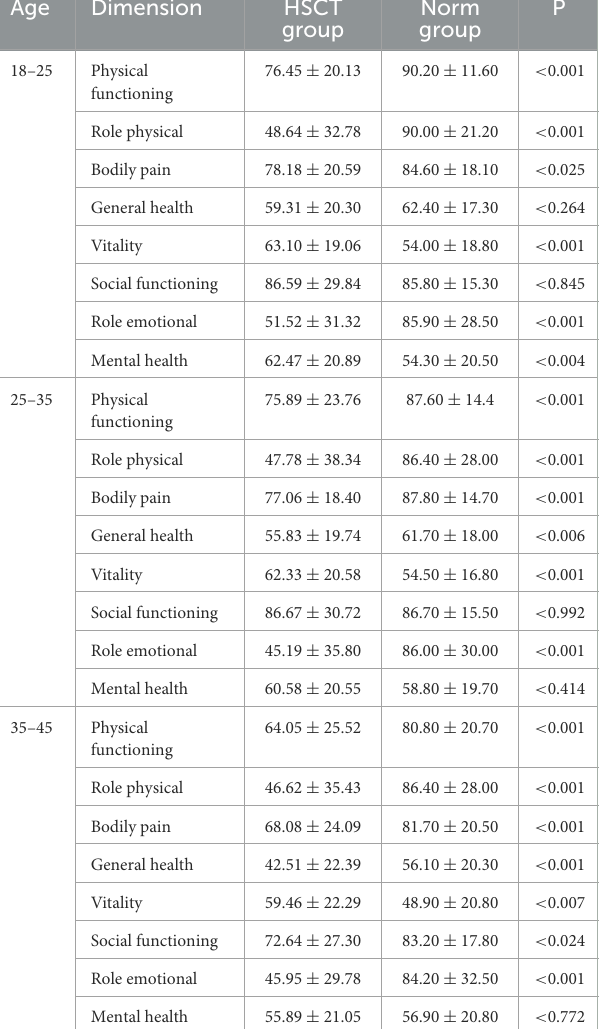
TABLE 3 The score of each dimension between participants after HSCT and the female norm of the same age group of the Sichuan population. Age Dimension HSCT